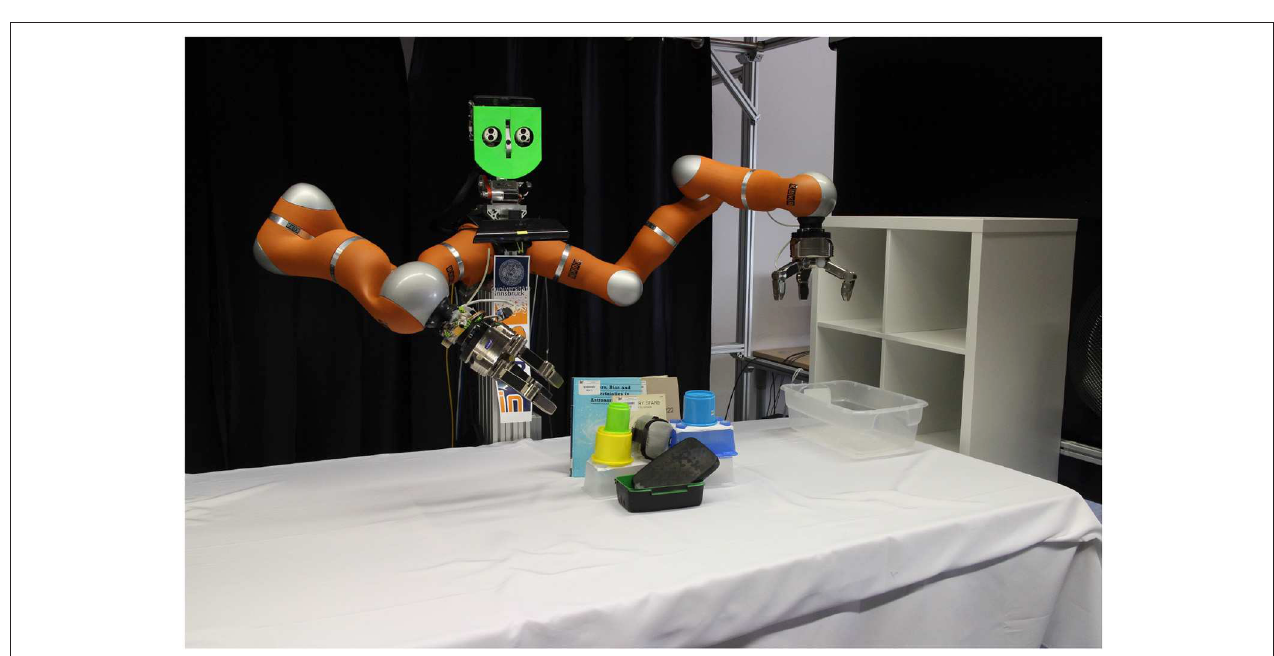
FIGURE 5 | Robot setting and used objects. The hardware included a Kinect, two KUKA LWR 4+ and two Schunk SDH grippers. The objects used for the trained tasks were books of different dimensions and cover types, an IKEA shelf and boxes, and selected objects of the YCB object and model set (Calli et al.,